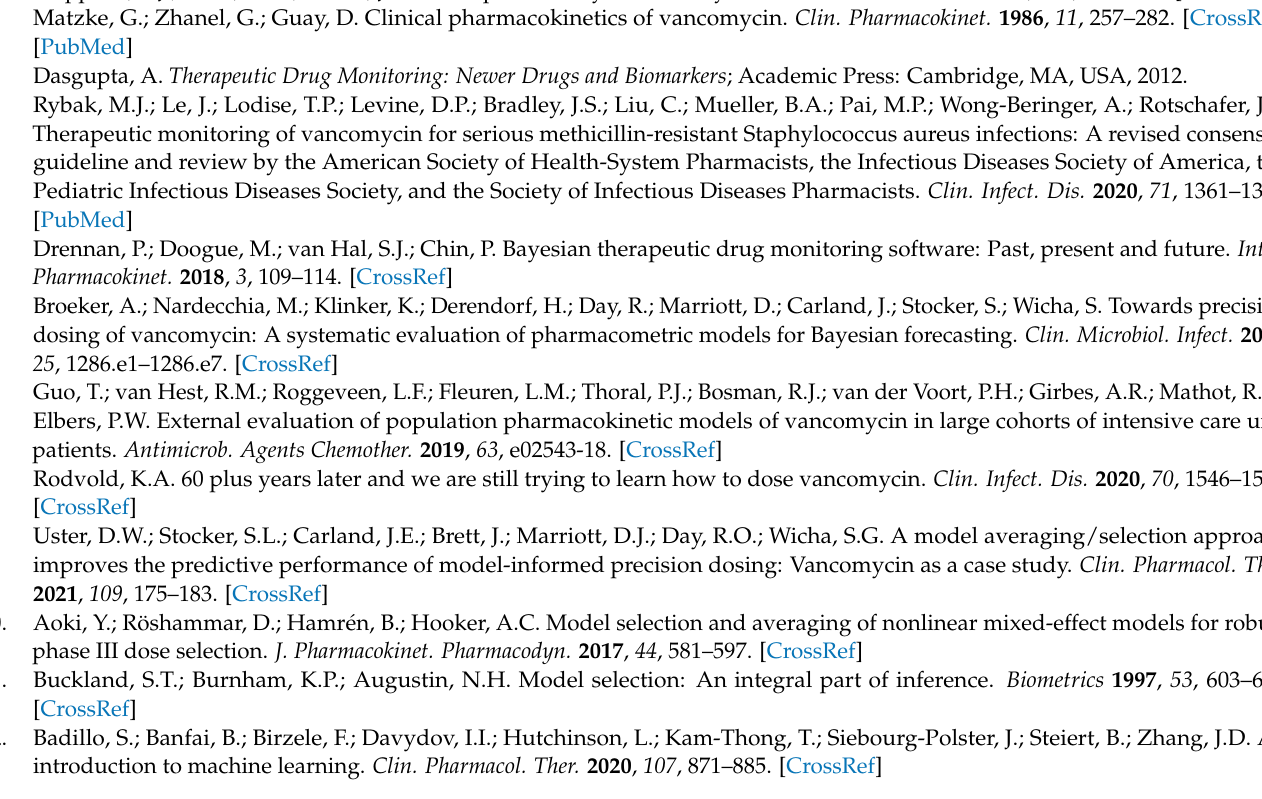
Figure S1. The feature importance plot of the XGBoost model in a single dose. The x-axis represents the XGBoost importance value of the feature, whereas the y-axis represents the concentration used for feature creation. Out of the 108 features created, 10 features with the highest importance values are presented. (A) Trough, (B) peak and trough, (C) peak, mid, and trough, and (D) one-hour interval sampling. Figure S2. The feature importance plot of the XGBoost model in the steady state. The x-axis represents the XGBoost importance value of the feature, whereas the y-axis represents the concentration used for feature creation. Out of the 108 features created, 10 features with the highest importance values are presented. (A) Trough, (B) peak and trough, (C) peak, mid, and trough, and (D) one-hour interval